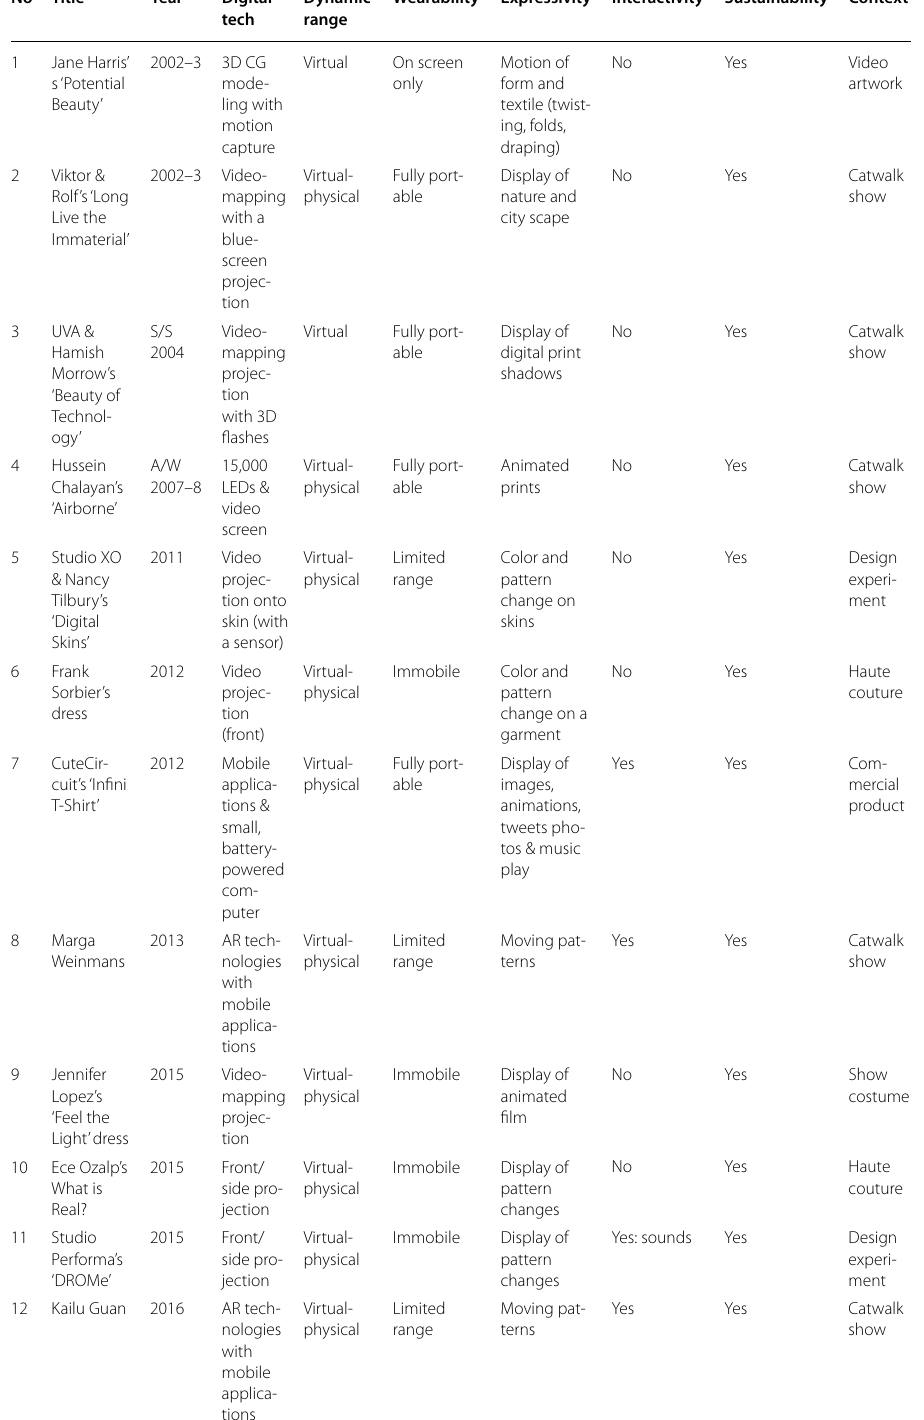
Table 1 Prior cases of virtual or virtual‑physical dynamic fashion design and its